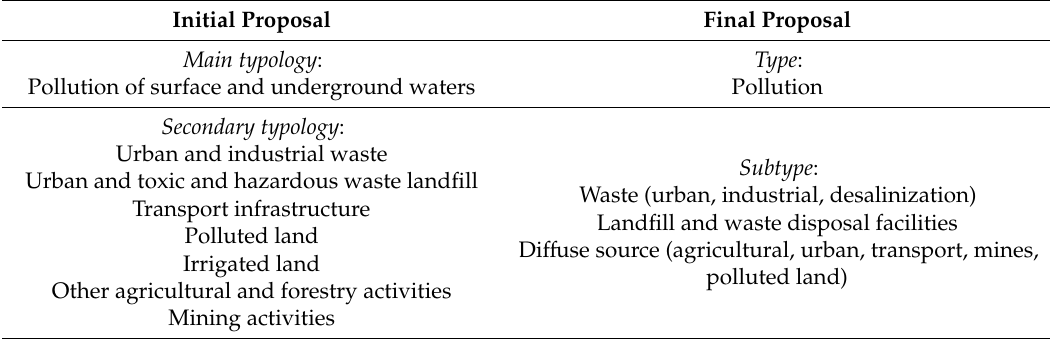
Table 1. Modifications made to the terminology used in conflict source categorization of the pollution of a surface and / or underground water